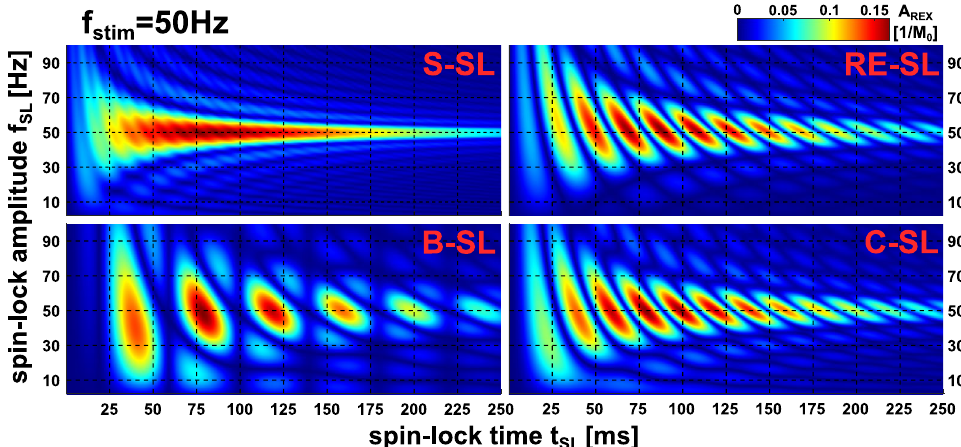
Figure 2. Simulation of the A REX characteristic for different spin-lock preparation modules with f stim = 50 Hz at various spin-lock frequencies f SL and various spin-lock pulse durations t SL . Here, f SL was varied from 2.5…100 Hz in 0.5 Hz steps and t SL was varied from 0.5…250 ms in 0.5 ms steps. (cid:31) B stim